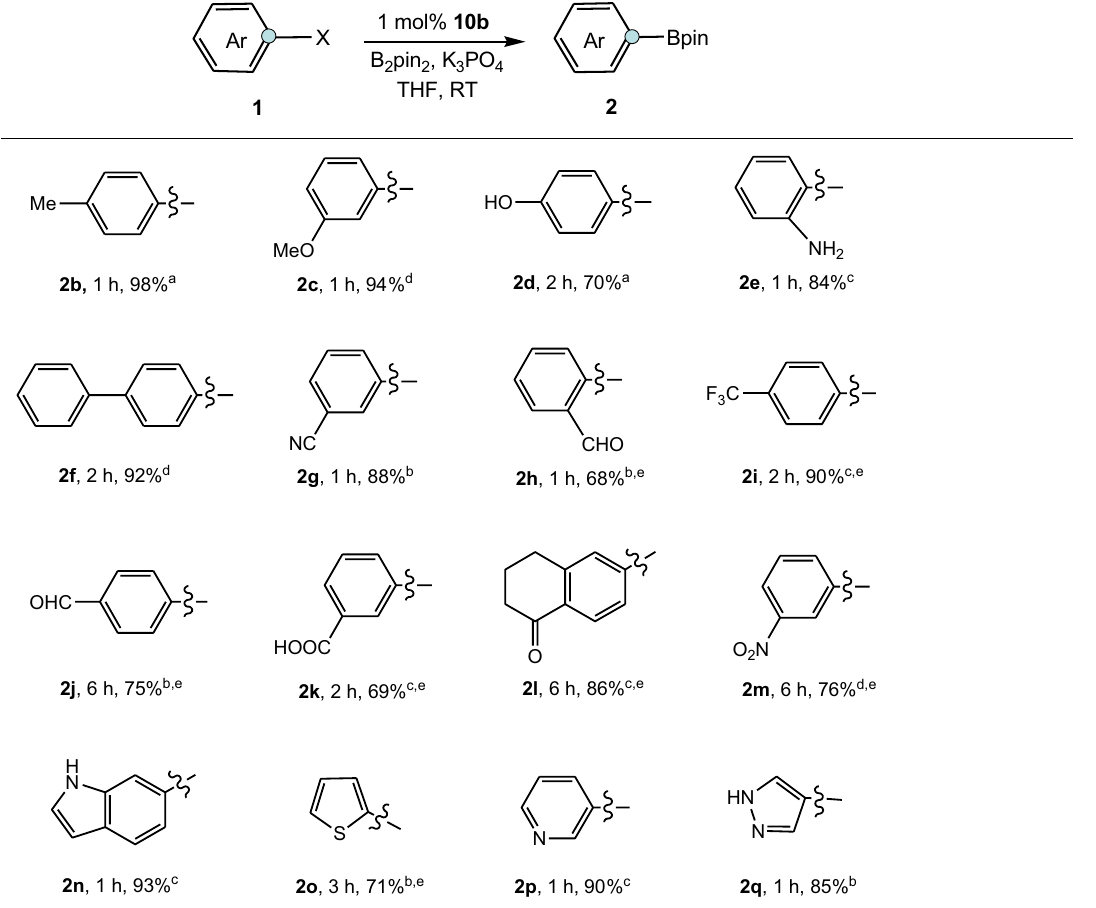
Table 2 Palladium-catalyzed borylation of aryl